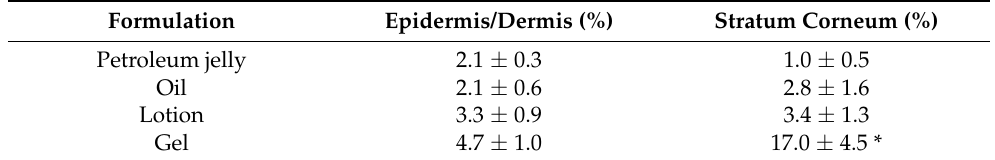
Table 2. In vitro skin deposition of BP-3 in the stratum corneum and the epidermis/dermis of excised rat skin after 48 h application of BP-3 formulations (mean ± S.D., n =